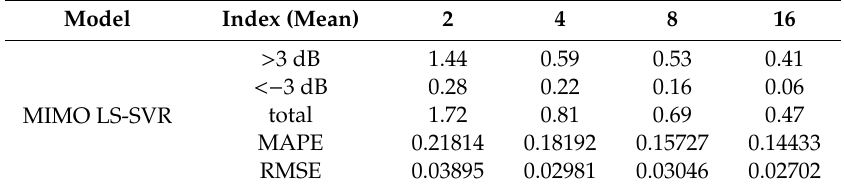
Table 5. Performance of the MIMO LS-SVR model under di ff erent number of measurement points.